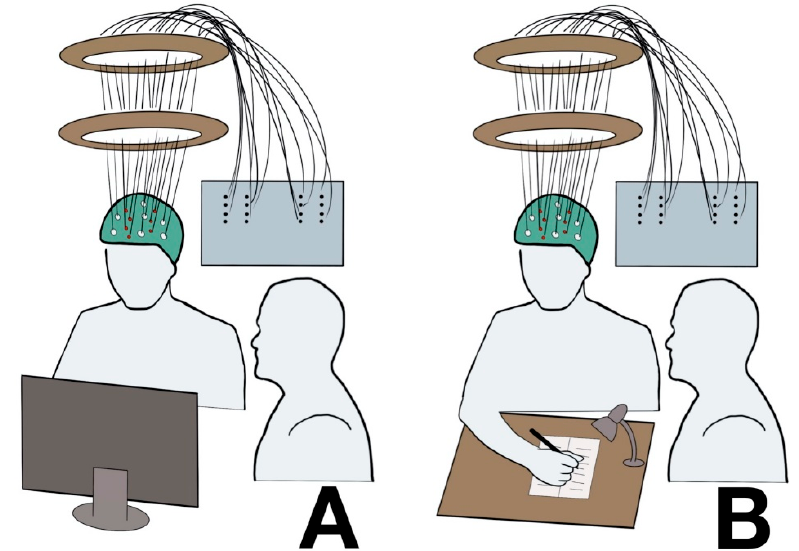
Figure 8. Representation of the test set-up. ( A ): Silent Word Generation (SWG), and Digit Span (DS) backward. ( B ): Symbol Search (SS).